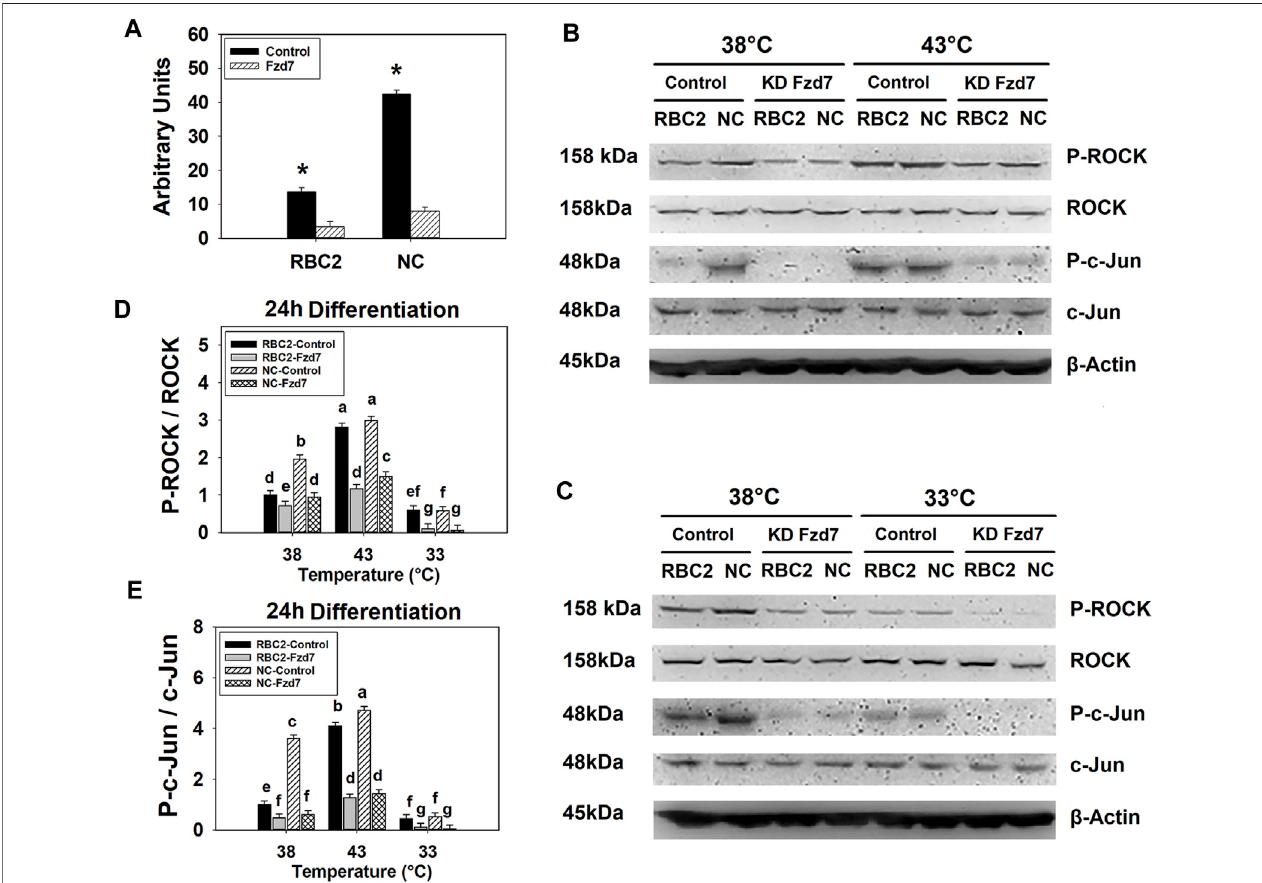
FIGURE 2 | Knockdown of frizzled-7 ( Fzd7 ) with small interfering RNA (siRNA) in satellite cells (SCs). (A) Expression of Fzd7 mRNA was measured at 72 h of proliferation after Fzd7 knockdown at the beginning of proliferation in Randombred Control Line 2 (RBC2) and modern commercial (NC) line SCs. Asterisk (*) above the barsrepresentsasigni fi cantdifferencebetweenthetwoadjacentgroups( p ≤ 0.05). (B) Westernblotsofunphosphorylatedandphosphorylatedformsofrho-associated protein kinase (ROCK) and c-Jun, and an internal control β -actin in SCs from the RBC2 and NC lines cultured at 38 ° C and 43 ° C was determined at 24 h of differentiation. (C) Western blots of the unphosphorylated and phosphorylated forms of ROCK and c-Jun, and an internal control β -actin in SCs from the RBC2 and NC linesculturedat38 ° Cand33 ° Cwasdetermined at24 hofdifferentiation. (D) TheratioofphosphorylatedtounphosphorylatedROCK. (E) Theratioofphosphorylatedto unphosphorylated c-Jun. Treatment group was above of each lane, and molecular weight and protein name is on the left and right side of each fi gure in (B and C) . Control = SCs transfected with a negative control siRNA, and KD Fzd7 = SCs transfected with a siRNA targeting Fzd7 in (B and C) . Each graph bar represents a mean ratio, and each error bar represents a standard error of the mean value. Mean values with different letters are signi fi cantly different ( p ≤ 0.05).